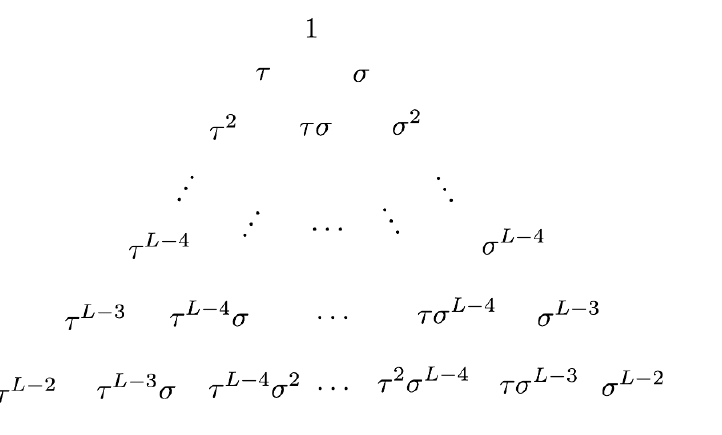
Figure 5 . R-symmetry monomials in f M